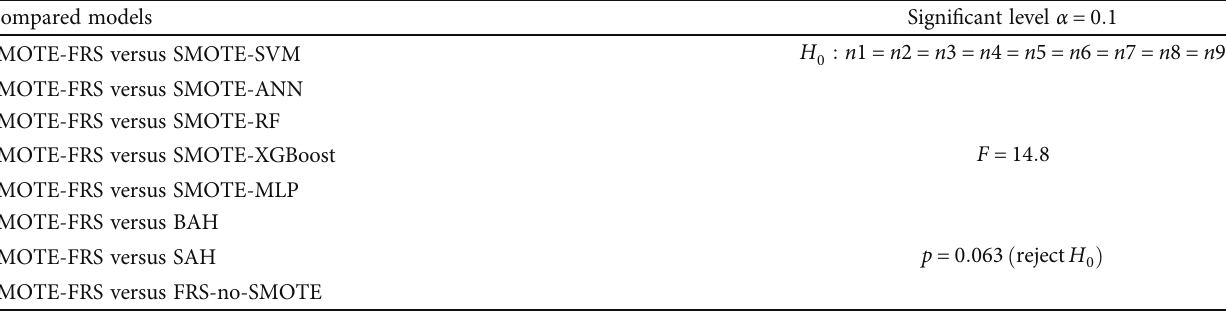
Table 10: The results of the Friedman test on accumulated return for SMOTE-FRS against the benchmark methods. Compared models Signi fi cant level α = 0 : 1 SMOTE-FRS versus